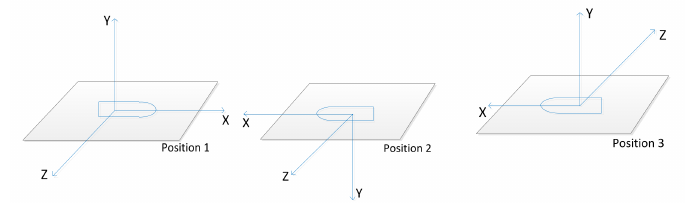
Figure 4. Diagram of rotation